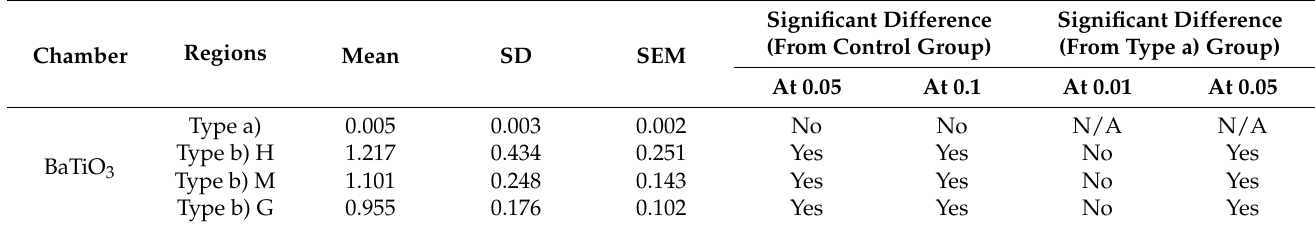
Table 3. Statistical analysis of the experimental results of Ba 2+ ion concentration